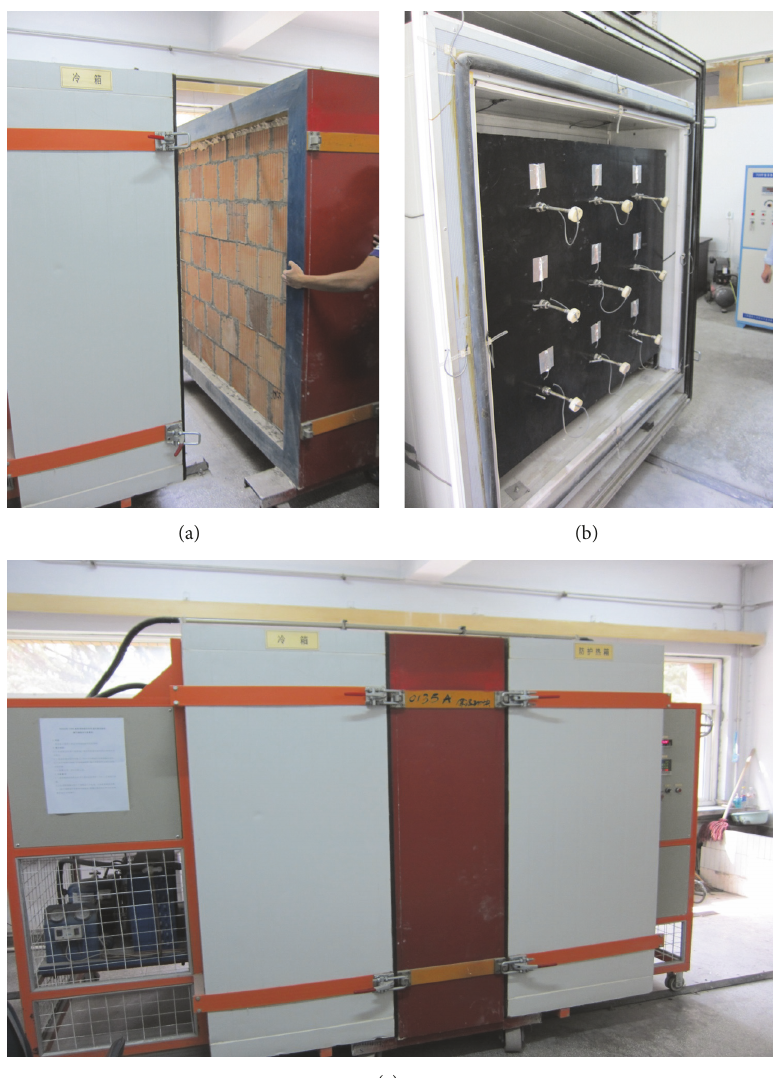
Figure 7: Testing